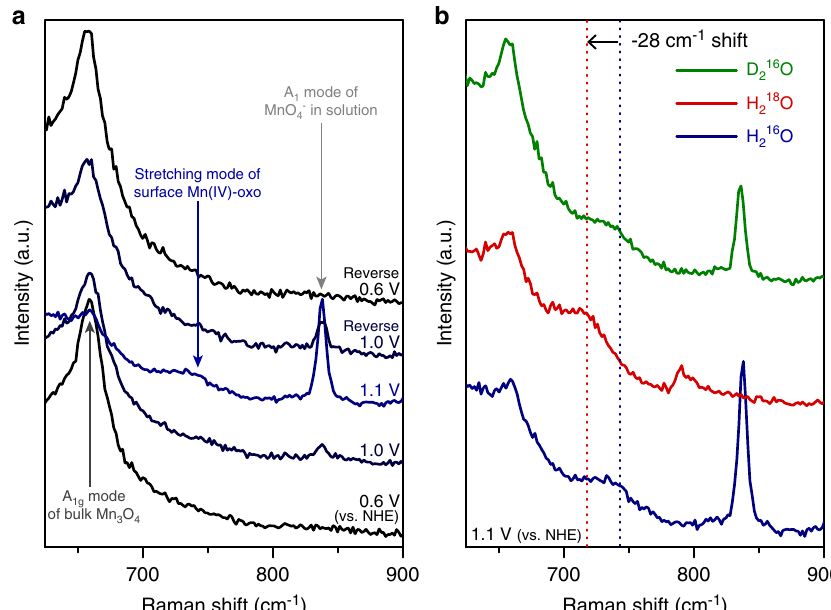
Fig. 6 In-situ Raman analysis. a Potential-dependent in-situ Raman spectra of Ni – Mn 3 O 4 NPs/NiO/FTO measured by increasing the applied potential from 0.6 V (vs. NHE) to the above of onset potential (1.1 V vs. NHE) and then decreased to the 0.6 V (vs. NHE). b In-situ Raman spectra during the water oxidation (1.1 V vs. NHE) under various electrolytes. The observed broad Raman peak found in H 2 16 O electrolyte (at 744 cm − 1 ) is red-shifted to 716 cm − 1 in 18 O labeled electrolyte, whereas there is no peak shift in the D 16 O 2